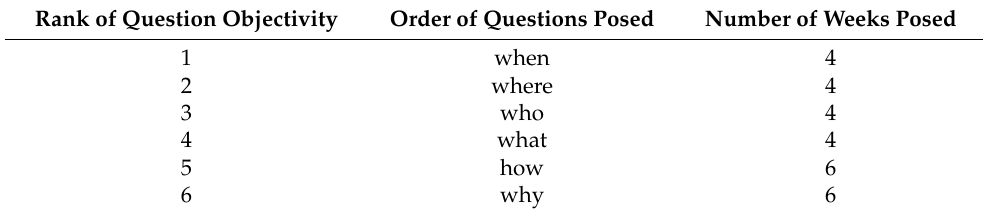
Table 3. Order of Each Type of Question Posed from the Most Objective to Most Subjective over the Weeks during the Academic Year and the Number of Weeks Each Type of Question Is the Focus. Rank of Question Objectivity Order of Questions Posed Number of Weeks Posed 1 when 4 2 where 4 3 who 4 4 what 4 5 how 6 6 why